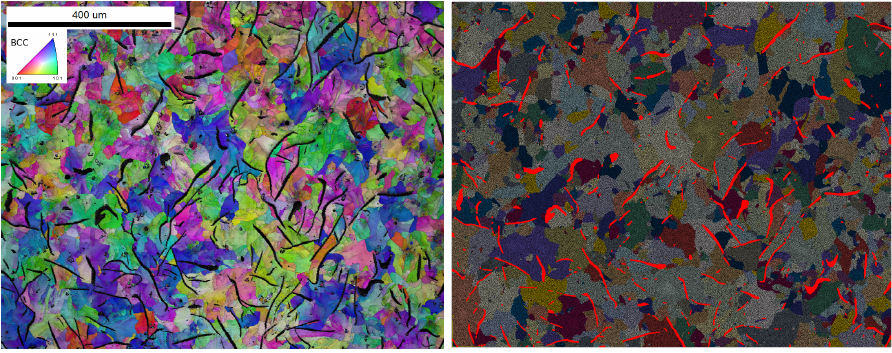
Figure 5. EBSD SEM images of the cast iron microstructure ( left ); example of a finite element model based on the EBSD map ( right ) typifying Model 3 .